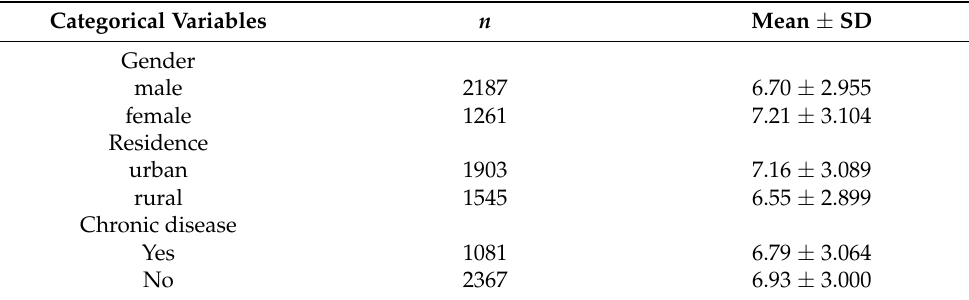
Table 3. Descriptive statistics of memory scores of categorical variables.